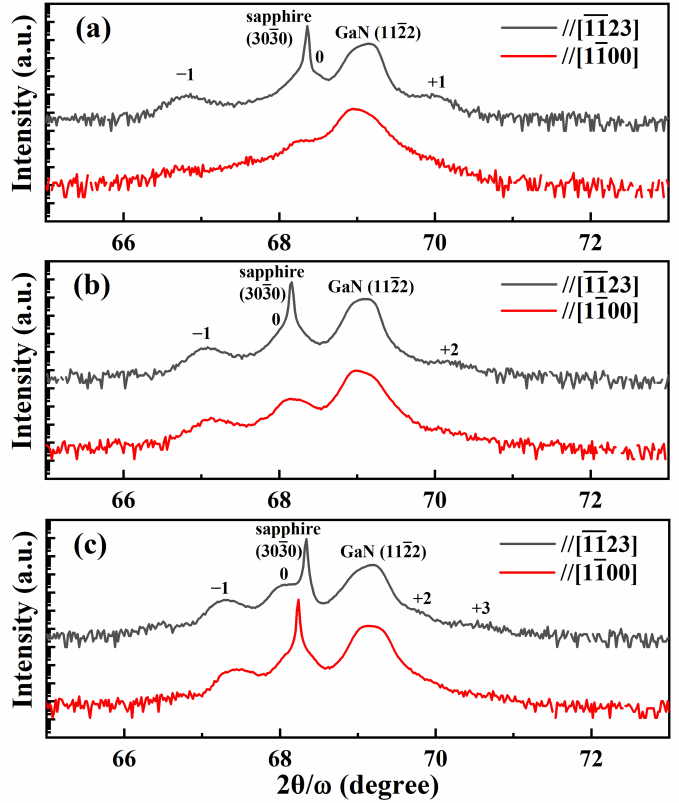
Figure 2. The 2 θ / ω scan profiles of the symmetric (1122) plane of the superlattice structures along the [1100] and the [1123] directions: ( a ) Sample A; ( b ) Sample B; ( c ) Sample